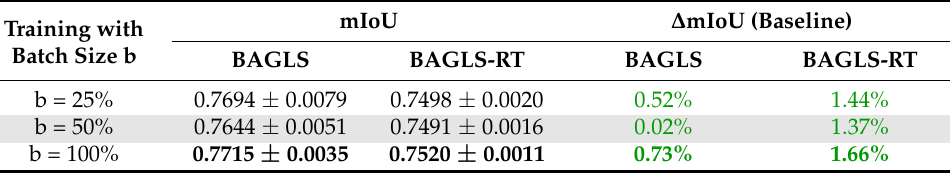
Table 3. Segmentation performance of the U-Net after incremental finetuning with mixed data from BAGLS and